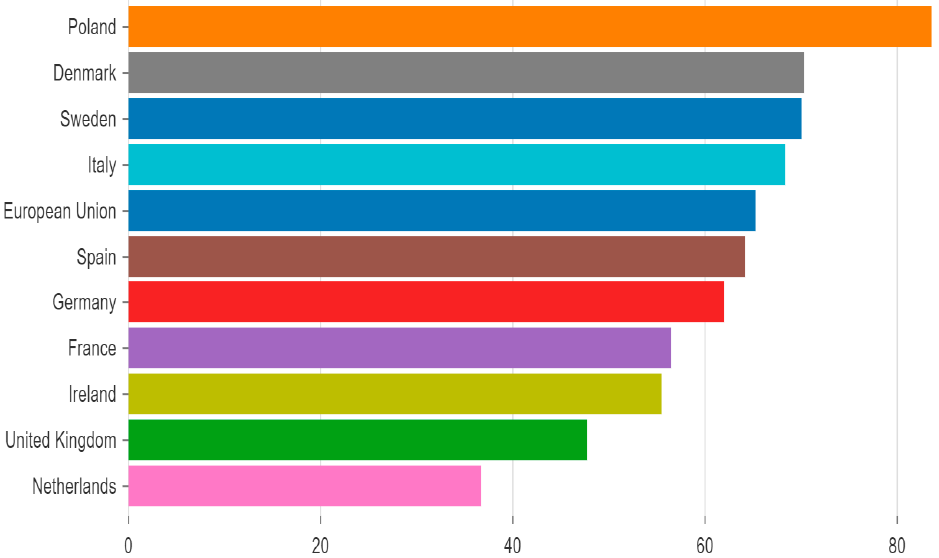
Figure 5. Spillover Score for Reaching Sustainable Development Goals. Source: European Sustainable Development Report 2021 [63].